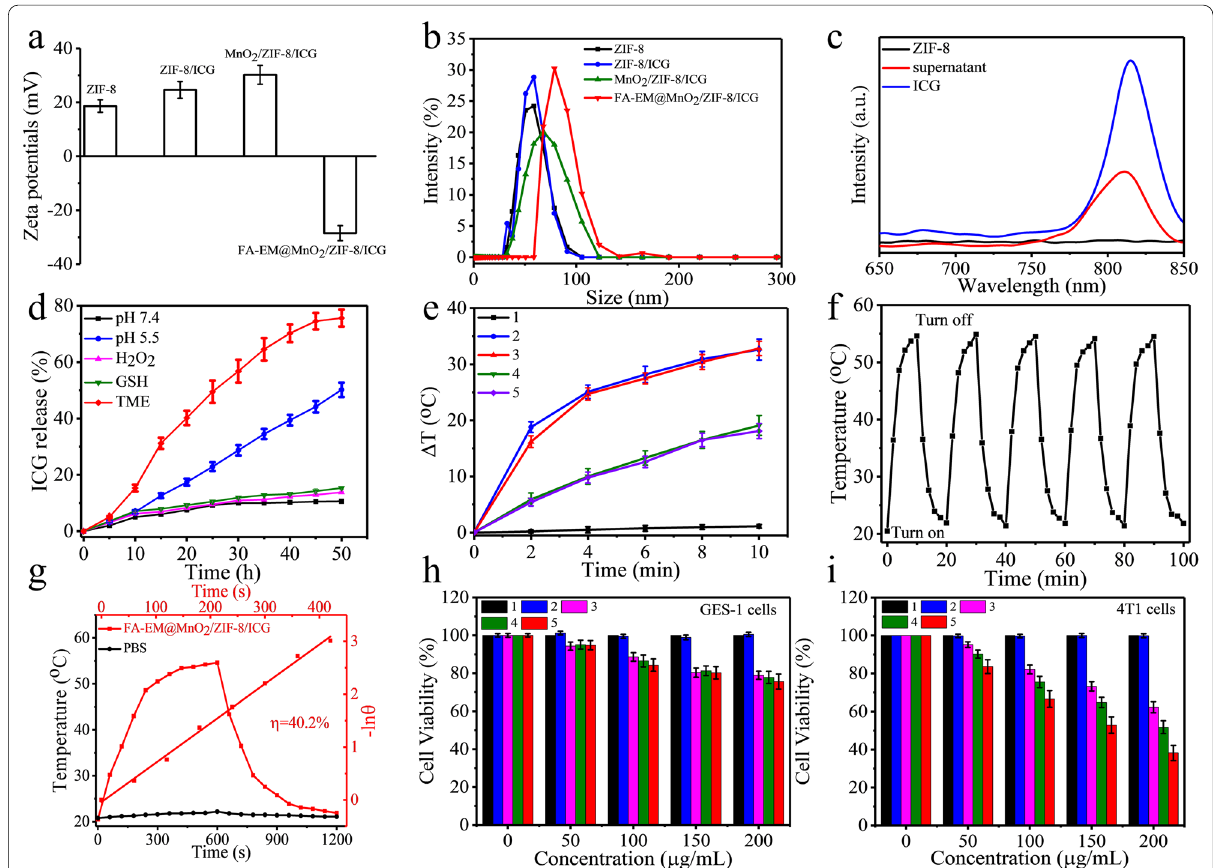
Fig. 2 a Zeta potential of ZIF-8, ZIF-8/ICG, MnO 2 /ZIF-8/ICG, and FA-EM@MnO 2 /ZIF-8/ICG. b Size distribution of ZIF-8, ZIF-8/ICG, MnO 2 /ZIF-8/ICG, and FA-EM@MnO 2 /ZIF-8/ICG. c Fluorescence spectra of ZIF-8, the ICG solution before loading, and the residual ICG in the supernatant after loading. d In vitro profiles of ICG release from FA-EM@MnO 2 /ZIF-8/ICG nano-platform under conditions of pH 7.4, pH 5.5, H 2 O 2 , GSH and simulated TME. e Temperature changes of PBS (curve 1), 200 μg/mL ZIF-8/ICG (curve 2), 200 μg/mL FA-EM@MnO 2 /ZIF-8/ICG (curve 3), and 150 μg/mL FA-EM@ MnO 2 /ZIF-8/ICG (curve 4) irradiated with 808 nm irradiation (2.0 W/cm 2 ) for 10 min, and 200 μg/mL FA-EM@MnO 2 /ZIF-8/ICG (curve 5) irradiated with 808 nm irradiation (1.5 W/cm 2 ) for 10 min. f Temperature changes of 200 μg/mL FA-EM@MnO 2 /ZIF-8/ICG disperse solution irradiation with 808 nm irradiation (2.0 W/cm 2 ) for five turn on/off cycles. g Photothermal response of FA-EM@MnO 2 /ZIF-8/ICG solution and H 2 O treated with an NIR irradiation (808 nm, 1.5 W/cm 2 ) for 600 s and then the irradiation was turned off. Viability of GES-1 cells ( h ) and 4T1cells ( i ) upon treated with PBS (1), PBS NIR (2), ZIF-8/ICG NIR (3), MnO 2 /ZIF-8/ICG NIR (4), and FA-EM@MnO 2 /ZIF-8/ICG NIR + + + +